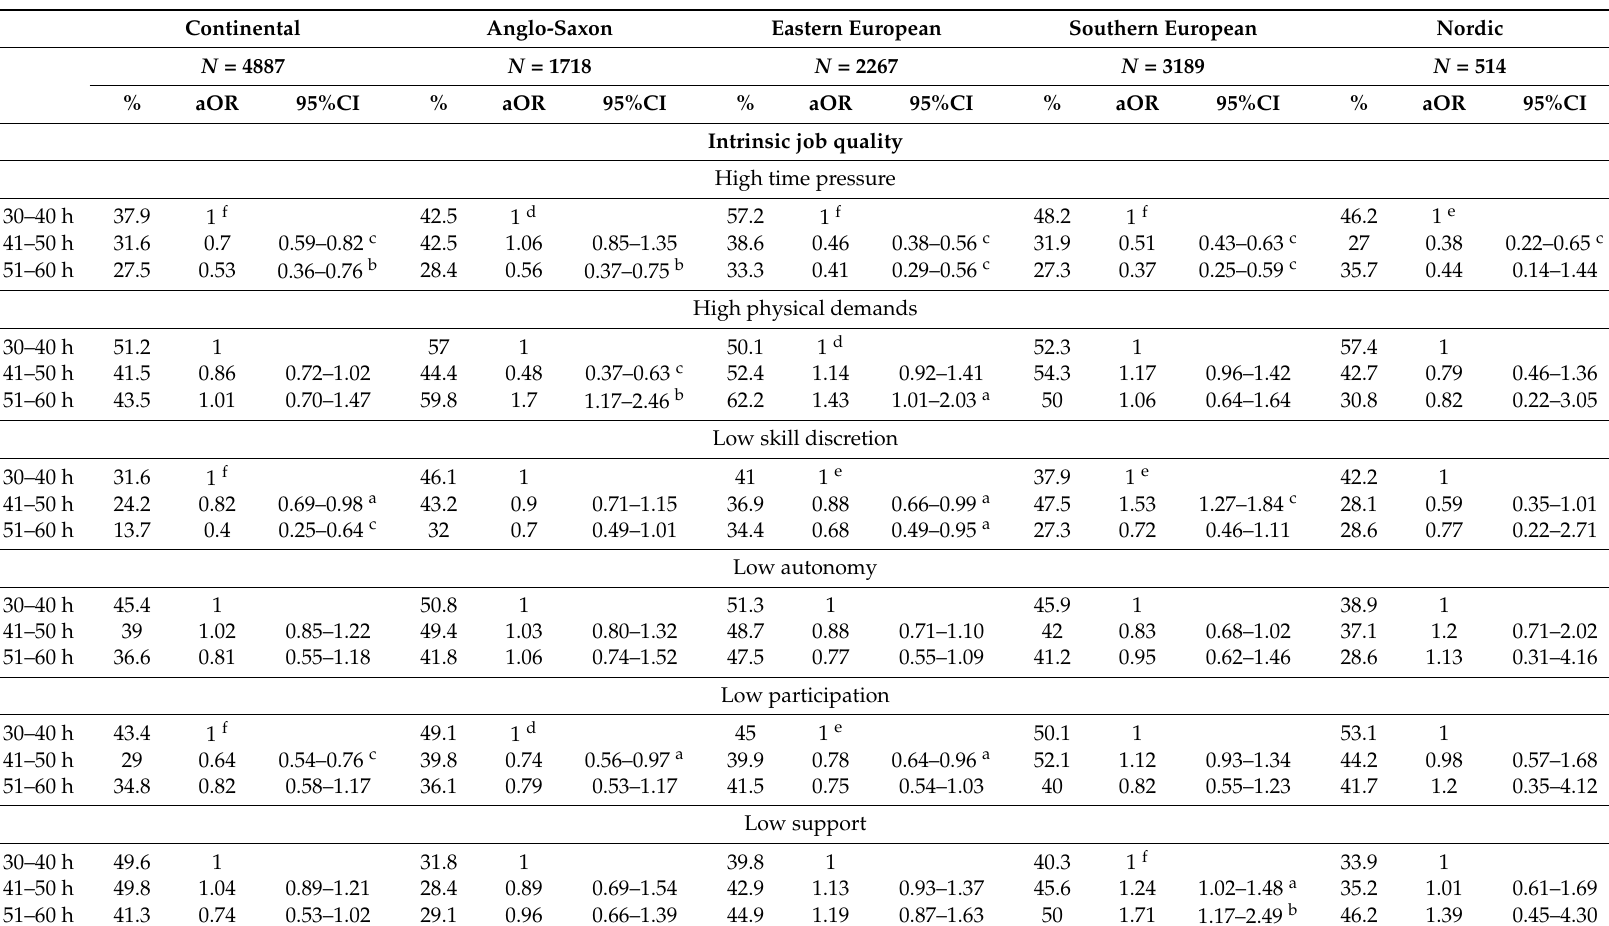
Table 2. Association of working time with poor job quality by country group among men. Adjusted odds ratios (aOR) and 95% confidence intervals (95% CI). Employees working 30–60 h a week. 5th European Working Conditions Survey,